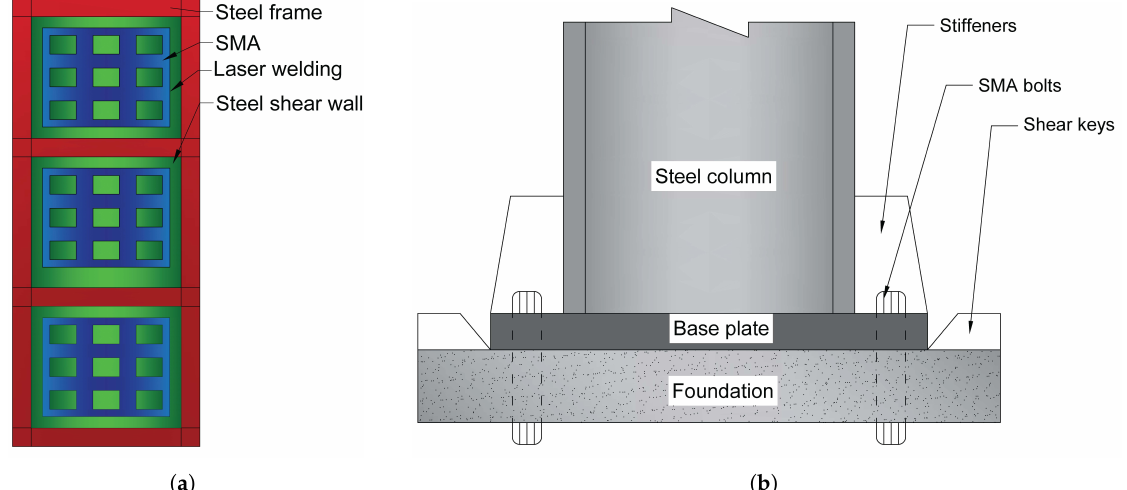
Figure 16. ( a ) The steel structure reinforced with steel shear walls and SMA fibre strands [71]; ( b ) Schematic of steel column and foundation connection with SMA bolts [72].